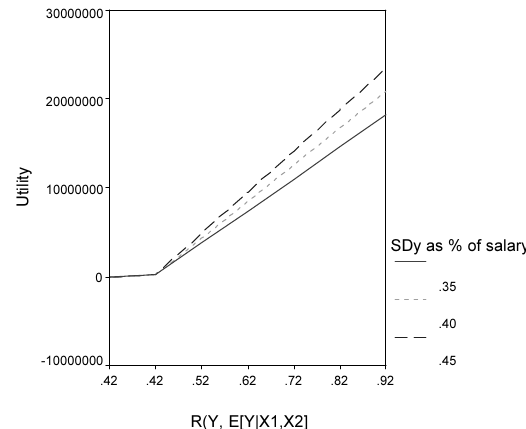
Figure 5: Incremental utility as a function of R(Y, E[Y|X 1 ,X 2 ] and SD